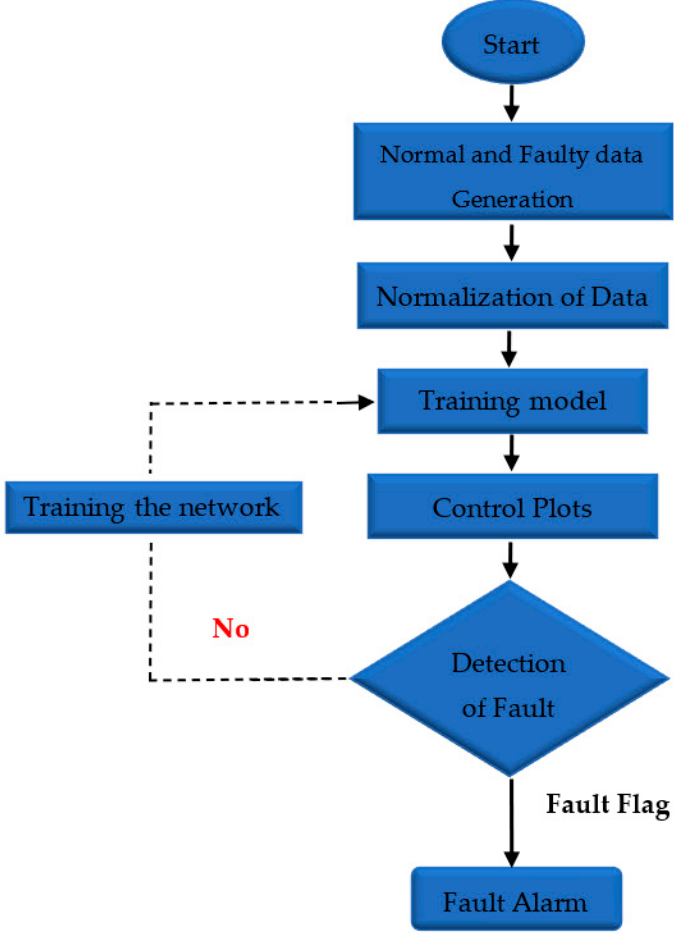
Figure 1. NARX network-based fault detection scheme .